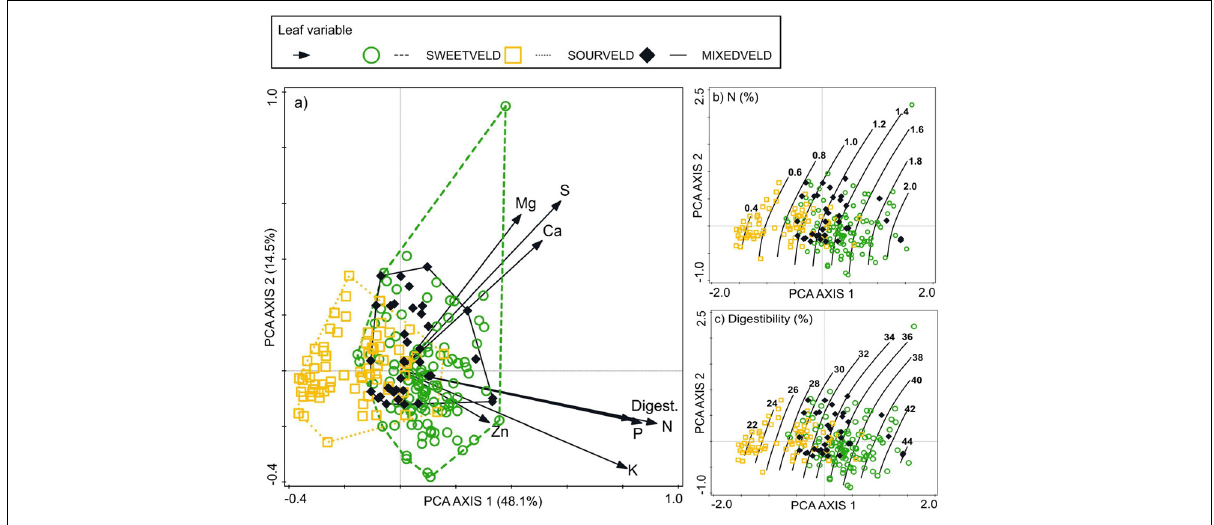
Figure 1: First two axes of a principal component analysis (PCA) of leaf variables measured at 31 locations in three grassland types in KwaZulu-Natal (a), and trend in leaf nitrogen (b) and digestibility (c) across the ordination.